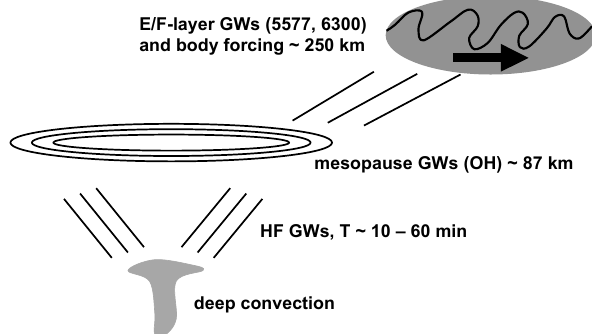
Fig. 1. Cartoon of GWs arising from deep convection, their propa- gation to higher altitudes, and their potential contributions to plasma perturbations, instabilities, and plasma bubble seeding. Slanted lines denote GW phase surfaces in a 2-D plane, rings denote air- glow signatures near the mesopause, and the shaded region denotes the bottomside F-layer with plasma density, velocity, and/or polar- ization electric field perturbations accompanying GW neutral per- turbations. The bold arrow indicates the body forcing accompany- ing GW dissipation at high